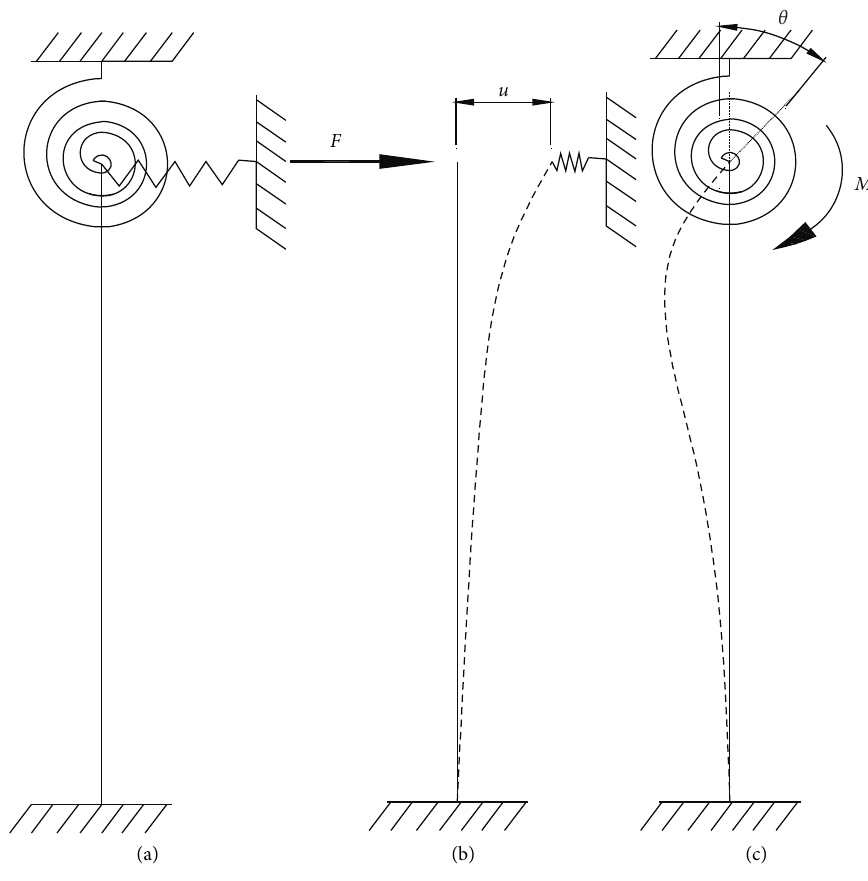
Figure 1: Boundary constraint calculation of the rigid pier